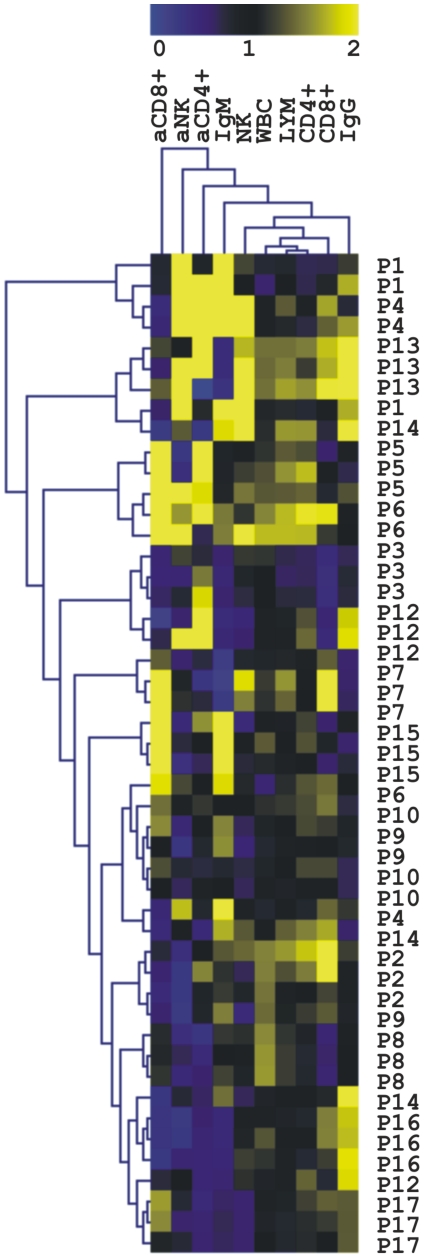
Variability of different lymphocyte subsets cell counts and antibody concentrations assessed in blood samples of healthy individuals.The HCA was performed both, for the analysis of samples and the variation of each parameter. The colour scale denotes increasing cell counts/concentrations of the measured parameters, with both extremes being low (blue) and high (yellow). The total numbers of leukocytes (WBC), lymphocytes (LYM), natural killer cells (NK), CD8+ and CD4+ T lymphocytes and their activated forms (aNK, aCD8+ T, aCD4+ T), were determined by flow cytometry. The concentrations of IgG and IgM antibodies are also included. Samples are marked by consecutive number of volunteer (P1–P17), volunteer gender (F, M) and sampling day (D1–5).